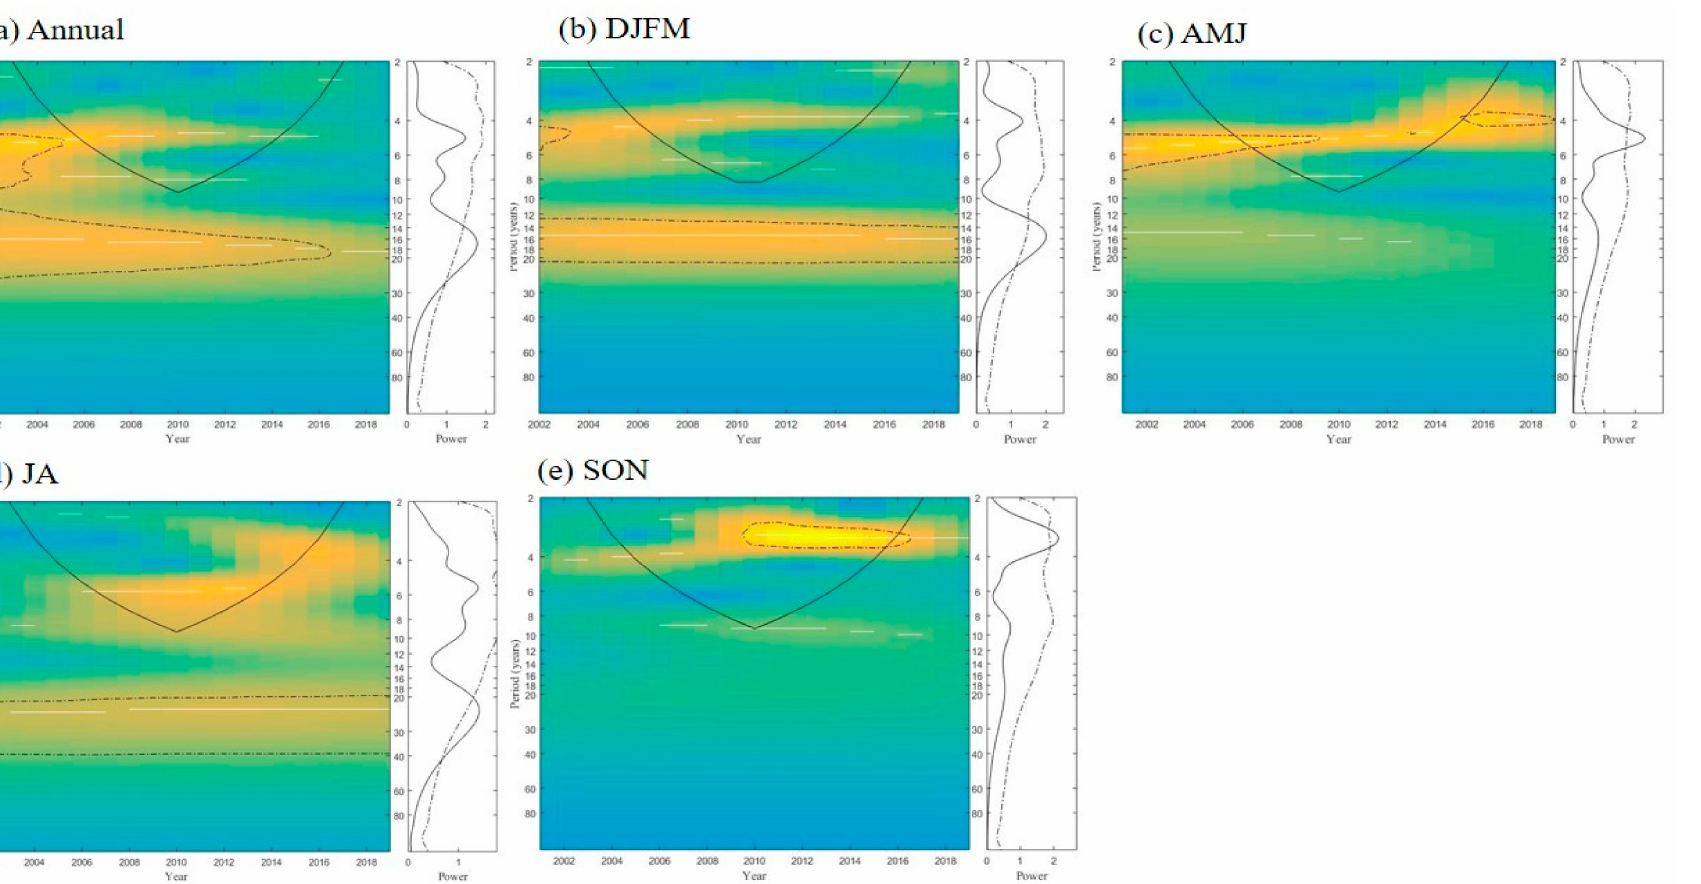
Figure 5. Wavelet analysis of normalized ( a ) annual and seasonal fire frequency: ( b ) December–March; ( c ) April–June; ( d ) July–August; ( e ) September–November. The line is the Cone of Influence beyond which the energy is contaminated by the effect of zero padding and the dashed contour line (on spectrum on the right) represents the 95% confidence level of local power relative to a red-noise